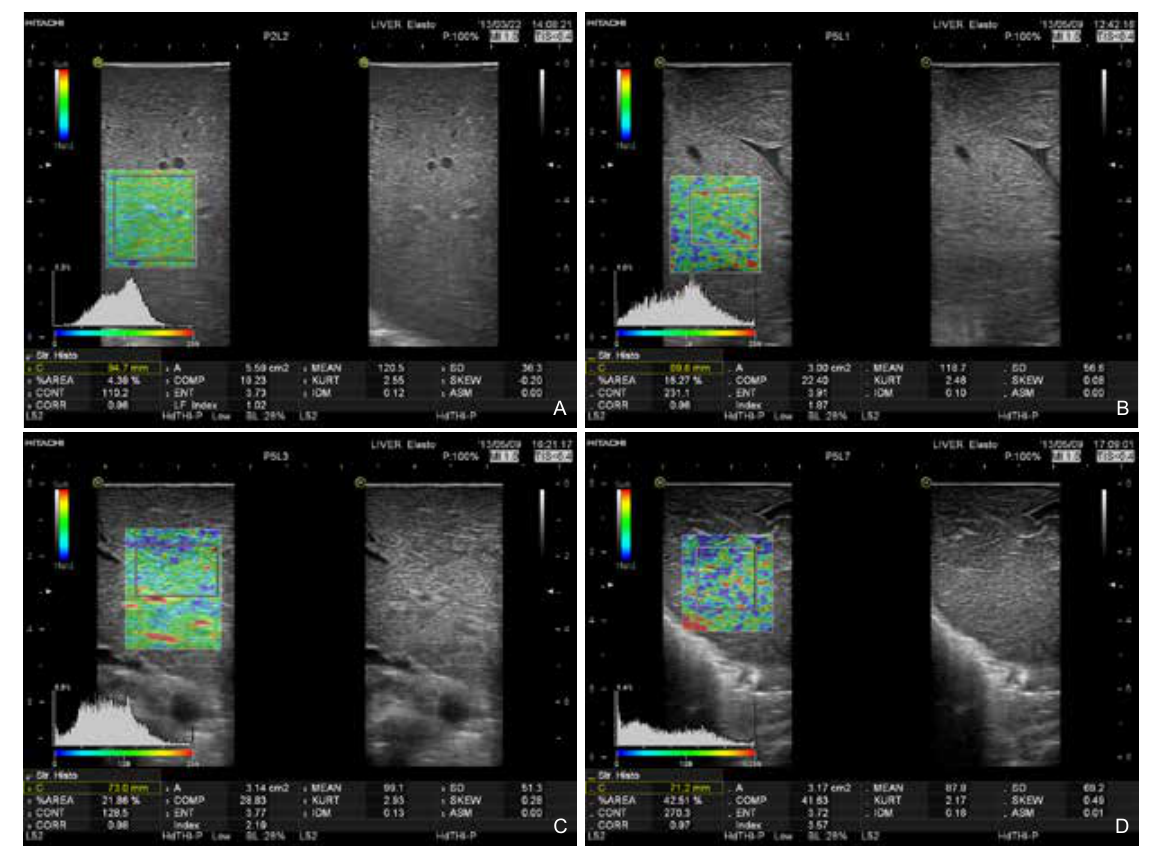
Figue 1 Real-time tissue elastography of liver parenchyma in Est-BD (A), 3 hours (B), 6 hours (C), and 9 hours (D) after brain death. In the elasticity images of the ROI, green represents average stiffness, red represents softer than average stiffness and blue represents harder than average stiffness. On RTE images, it was observed that the blue area gradually increased with time after brain death, indicating a gradual decrease in liver